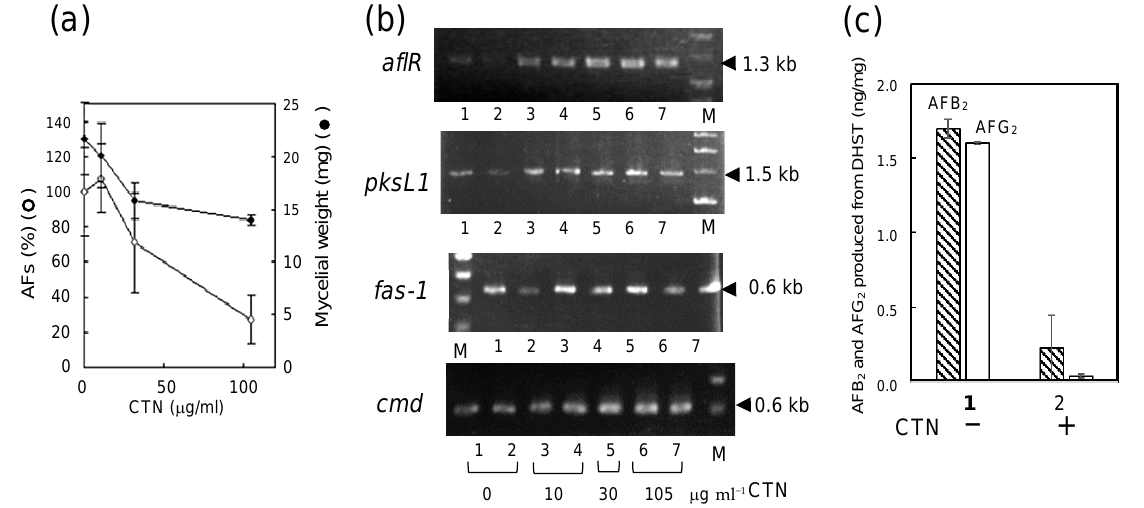
Figure 3. The effect of CTN on aflatoxin production, fungal growth, and gene expressions of aflatoxin biosynthesis genes: ( a ) The measurement of aflatoxin production and fungal growth by the tip culture method, the SYS-4 was cultured with various concentrations of CTN for 4 days, AFs in the resulting media were analyzed by HPLC, and the mycelial wet weight was measured, one hundred percent of the total AFs: 1.99 ± 0.24 μg ml − 1 ; ( b ) the effects of CTN on the gene expression of aflatoxin biosynthesis genes, after the tip cultures of SYS-4 in ( a ), RNA fractions were prepared from the resulting mycelial mats, and RT-PCRs were then performed for aflatoxin biosynthetic genes ( aflR , pksL1 , and fas-1 ), and a housekeeping cmd gene; ( c ) the effect of CTN on the conversion of DHST to AFB 2 as well as AFG 2 in the feeding experiment, after A. parasiticus NIAH-26 was incubated with 40 μM DHST in the absence or the presence of 0.105 mg ml −1 CTN using tip culture method for 4 days, AFB 2 and AFG 2 in the resulting media were analyzed by HPLC, mycelial weights: lane 1, 17.6 ± 0.4 mg and lane 2, 13.7 ± 2.1 mg.